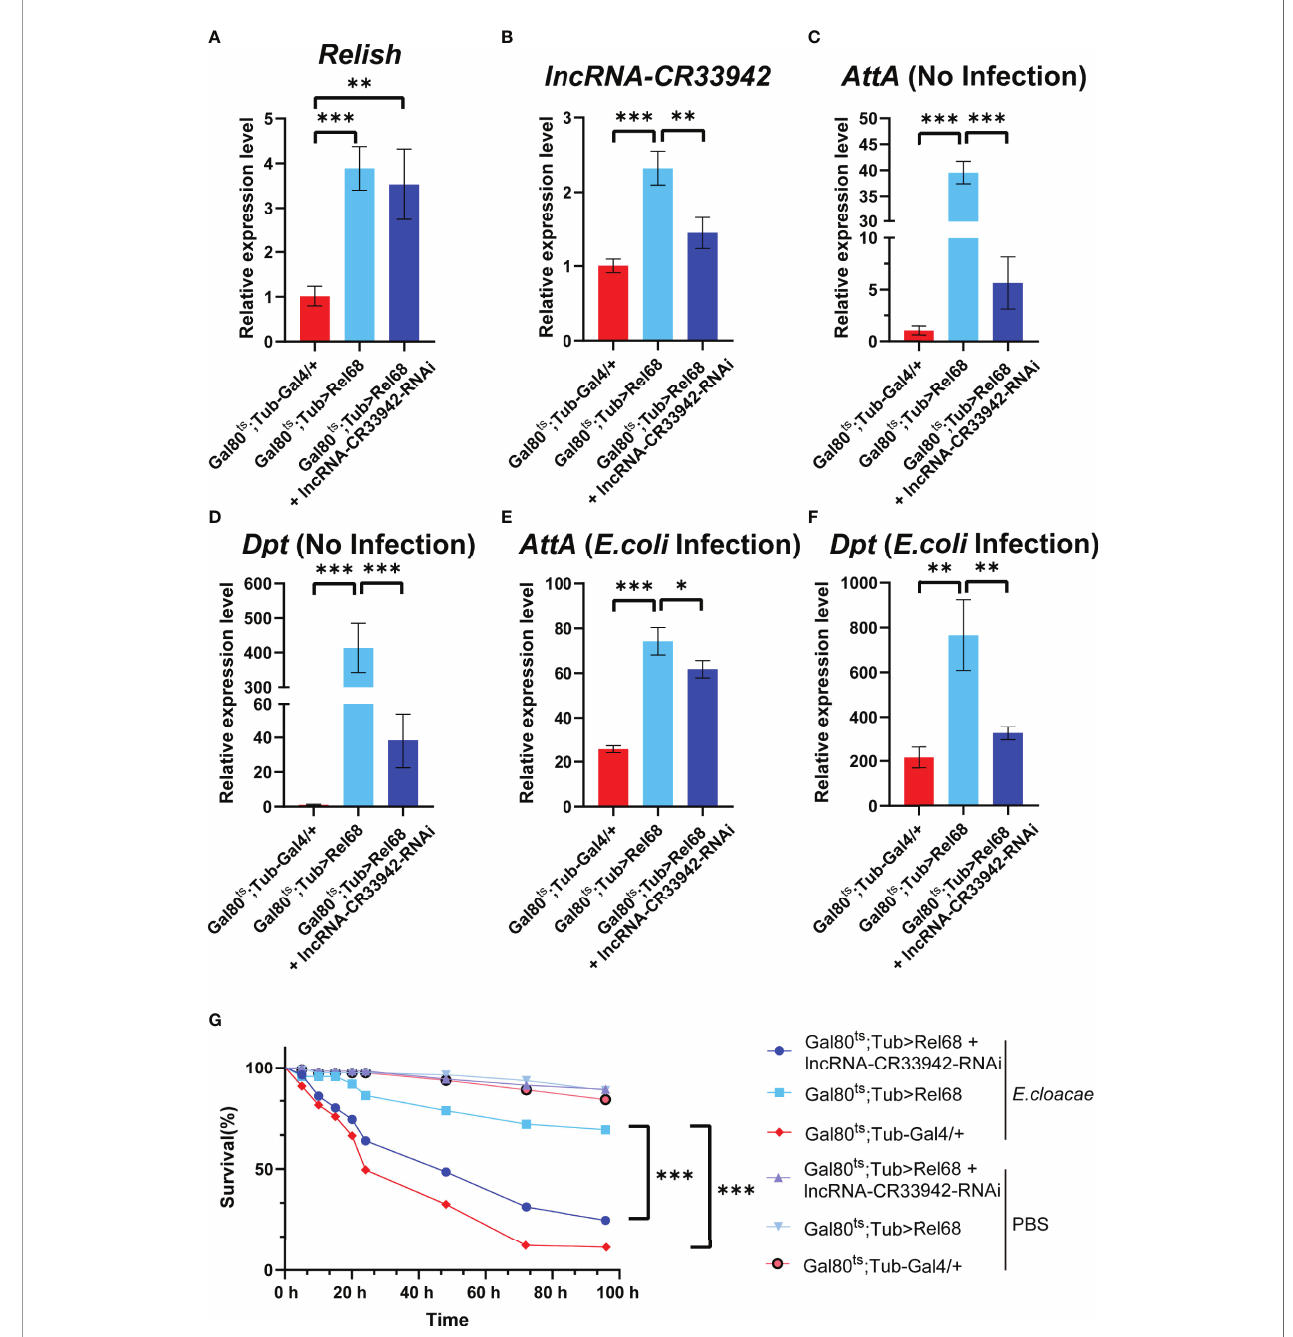
FIGURE 5 | Relish promotes lncRNA-CR33942 transcription to enhance Imd immune response. The expression levels of Relish (A) and lncRNA-CR33942 (B) in Rel68 overexpressing and Rel68 + lncRNA-CR33942 -RNAi co-overexpressing fl ies. AttA and Dpt expression levels in Rel68 overexpressing and Rel68 + lncRNA- CR33942 -RNAi co-overexpressing fl ies with no infection (C, D) and 12 h post-infection (E, F) . (G) Changes in the survival rate of the Rel68 overexpressing, Rel68 + lncRNA-CR33942 -RNAi co-overexpressing, and control fl ies were measured at 96 h after being treated with PBS or Enterobacter cloacae. Gal80 ts ; Tub-Gal4/+ - PBS (n = 109), Gal80 ts ; Tub> Rel68 - PBS (n = 107), Gal80 ts ; Tub> Rel68 + lncRNA-CR33942-RNAi - PBS (n = 104), Gal80 ts ; Tub-Gal4/+ - E. cloacae (n = 107), Gal80 ts ; Tub> Rel68 - E. cloacae (n = 109), Gal80 ts ; Tub> Rel68 + lncRNA-CR33942-RNAi - E. cloacae (n = 105). *P < 0.05; **P < 0.01; ***P <